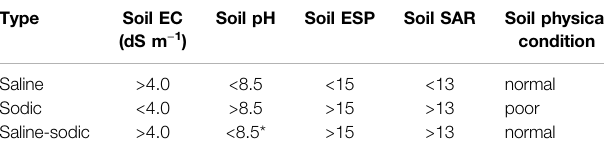
TABLE 1 | Classi fi cation of salt-affected